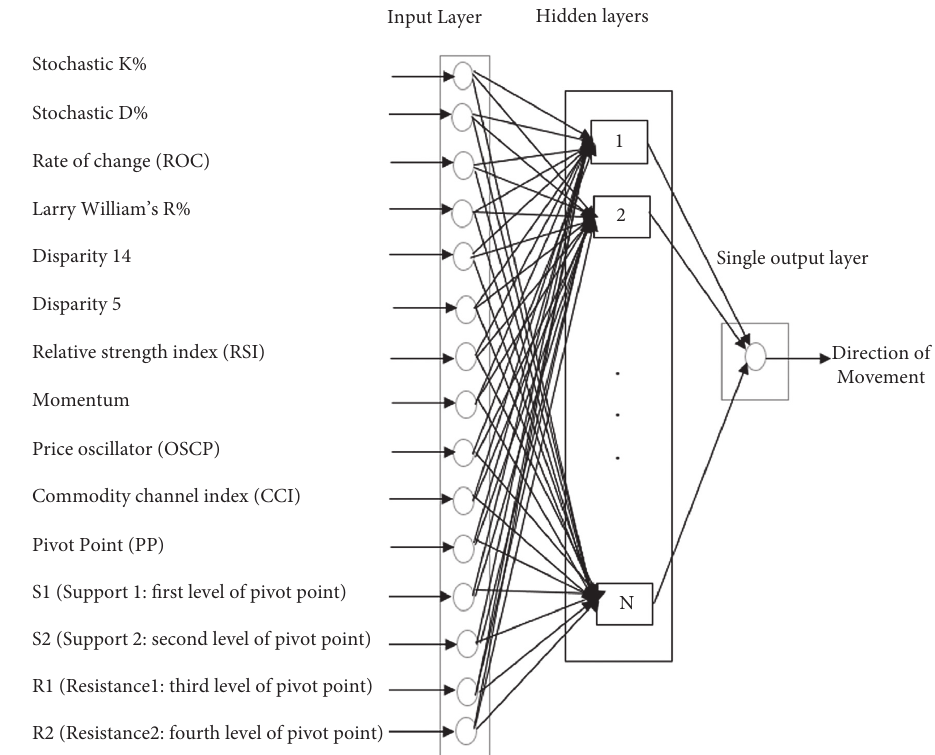
Figure 1: The architect of N hidden layers feed-forward neural